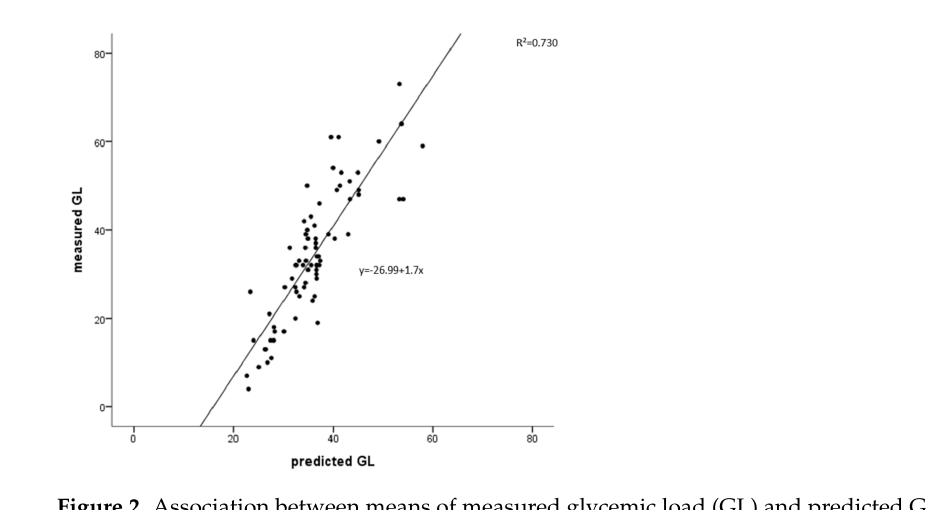
Figure 2. Association between means of measured glycemic load (GL) and predicted GL for 73 dif Figure 2. 0.730, p =